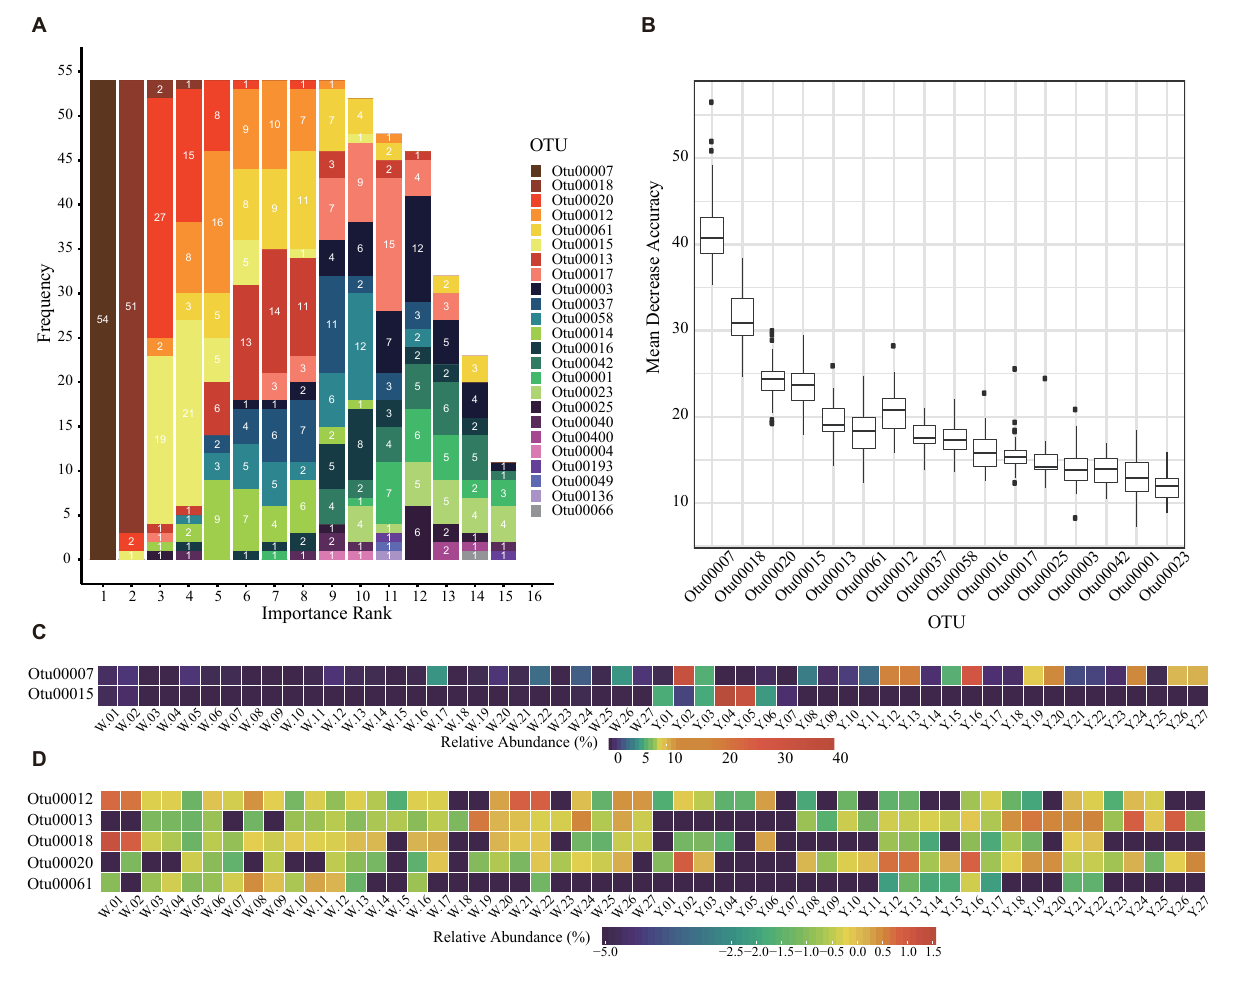
FIGURE 2 | Seven marker OTUs selected with Leave-One-Out Cross Validation (LOOCV). (A) The rank of OTUs in LOOCV with random forest classifier. The labels are all feature OTUs in a total of 54 classifier. The x axis is the rank and the y axis is the frequency of each rank. The number in each bar is the frequency of each OTU in each rank. The OTUs with sum of numbers greater than 50 are identified as marker OTUs. (B) The mean decrease accuracy boxplot of OTUs in the 54 random forest classifiers for LOOCV. The present OTUs are used in more than 10 classifiers. (C,D) The relative abundance of the seven marker OTUs in 54 immature starters. (C) The relative abundances are percentages (x%). (D) The relative abundances are percentages transformed with formula log 10 (relative abundance +